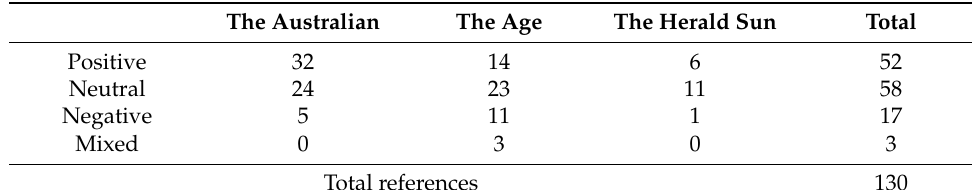
Table 6. Christianity—tone of references coded across the